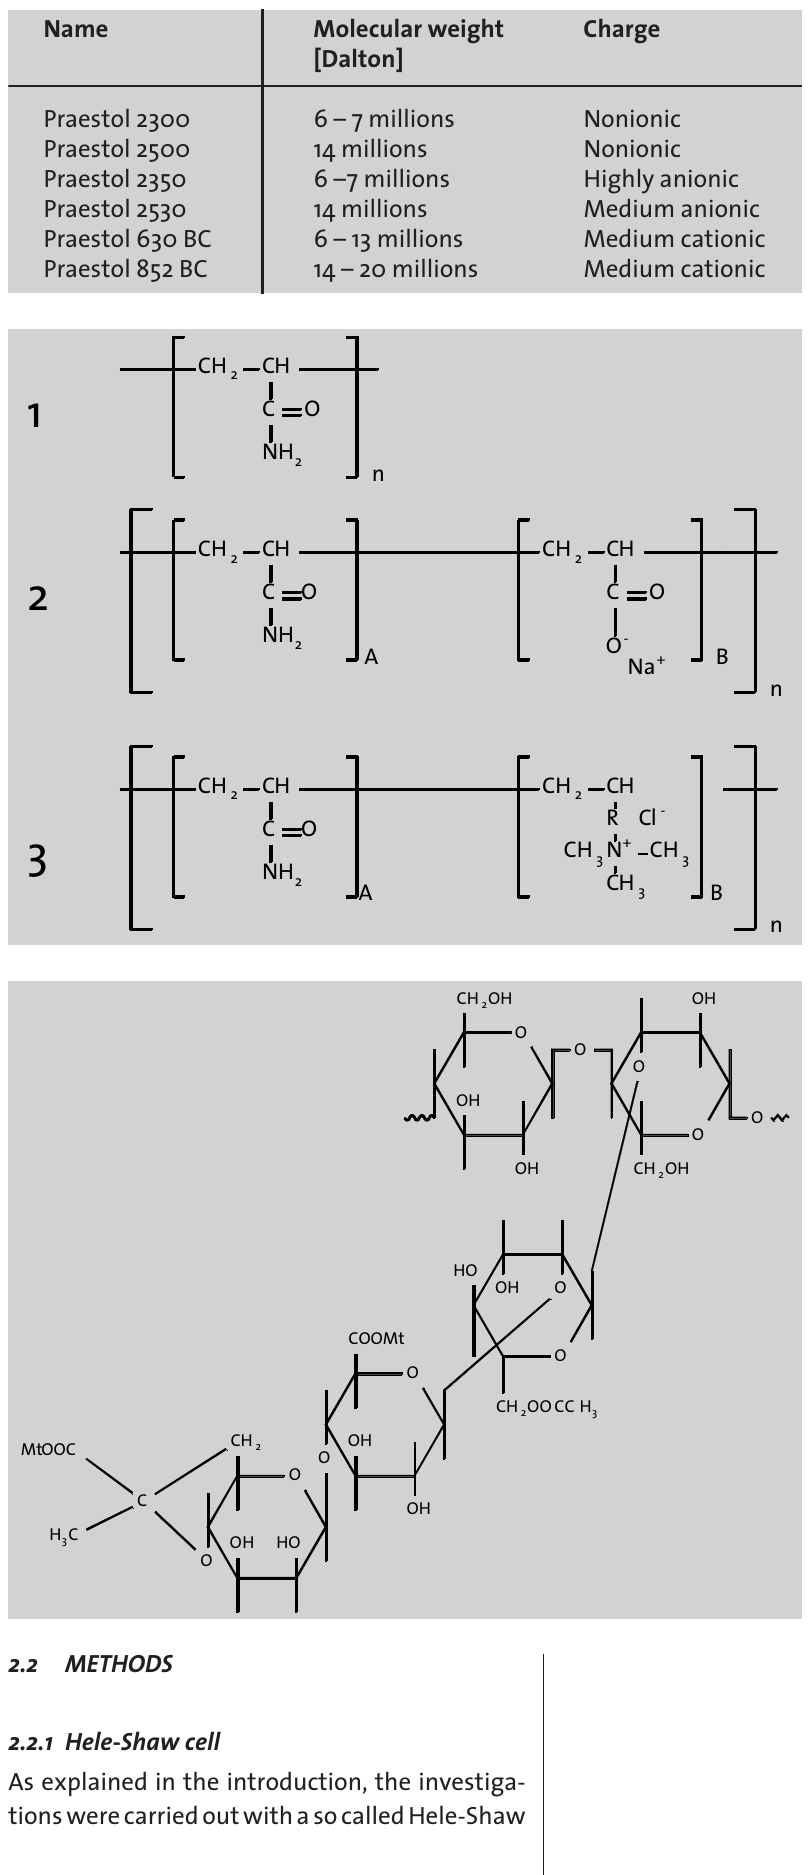
Table 1 (right above): Molecular weight and charge of the used polyacrylamides [8]. Figure 1 (right middle): Chemical formula of PAM (Charge: 1. nonionic, 2. anionic, 3. cationic [8]). Figure 2 (right below): Structural formula of Gum Xanthan